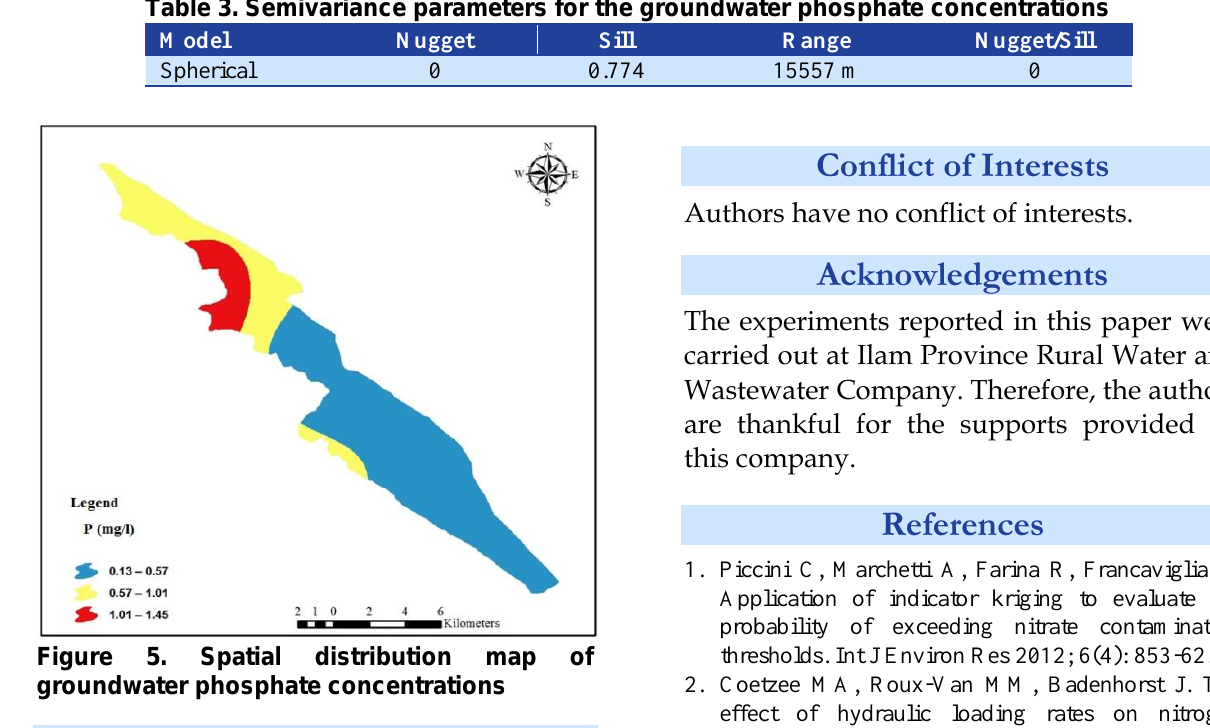
Figure 5. Spatial distribution map of groundwater phosphate concentrations